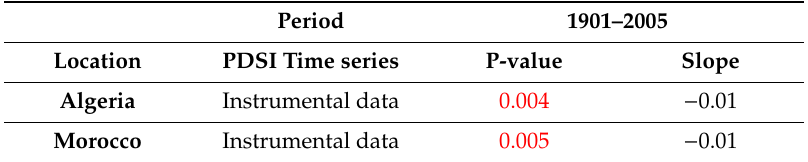
Table 7. Results of modified Mann–Kendall test of trend detection applied to observed PDSI over 1901–2005 in Morocco and Algeria. (Red indicates significance, with a p -value <